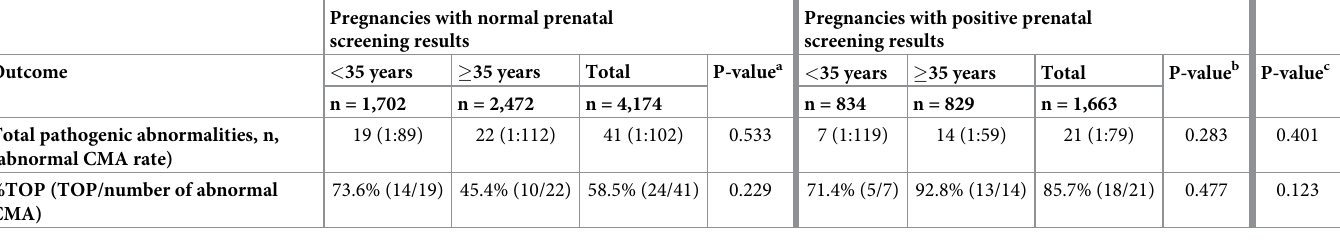
Abbreviations: CMA, chromosomal microarray analysis; TOP, termination of pregnancy. a P-values for the comparison between maternal age groups of pregnancies with normal prenatal screening results. b P-values for the comparison between maternal age groups of pregnancies with positive prenatal screening results. c P-values for the comparison between pregnancies with normal versus positive prenatal screening